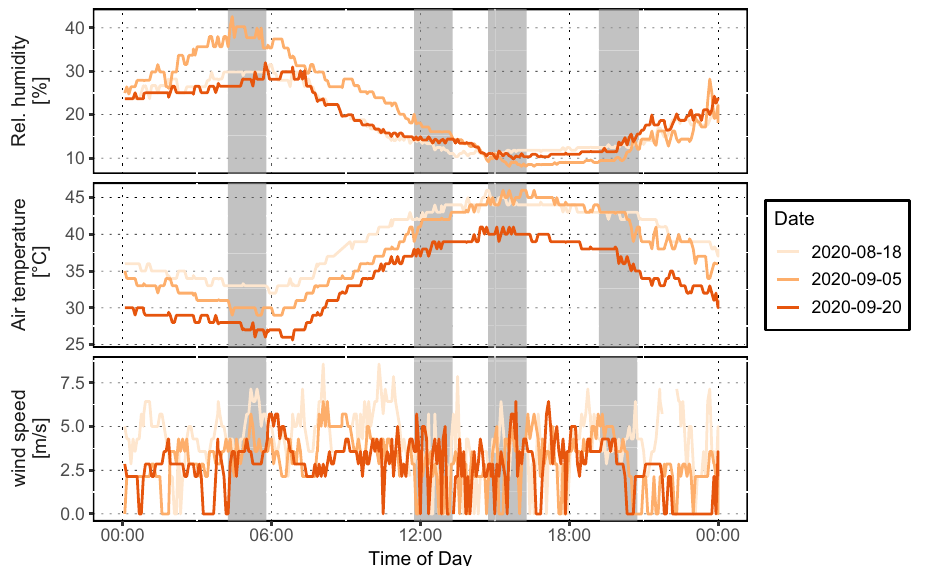
Fig. 1 | Diurnal meteorological data pro fi le for Phoenix. Diurnal meteorological data pro fi le from Phoenix Sky Harbor airport for mesoscale meteorological con- ditions.Relativehumidity,airtemperature,andwindspeedareshownforthe3days